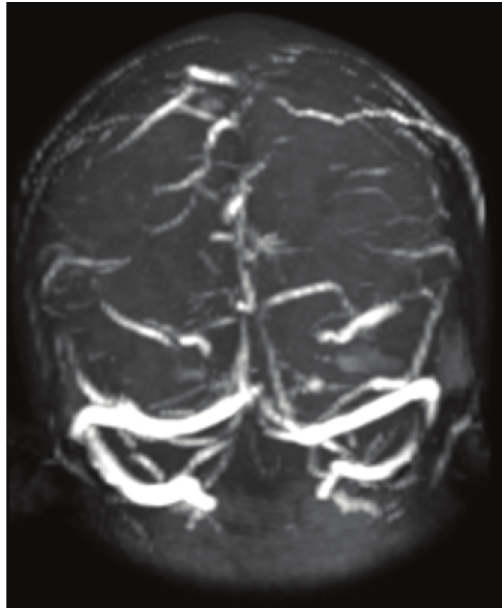
Figure 1: Magnetic resonance venography of the brain with supe- rior longitudinal sinus thrombosis.